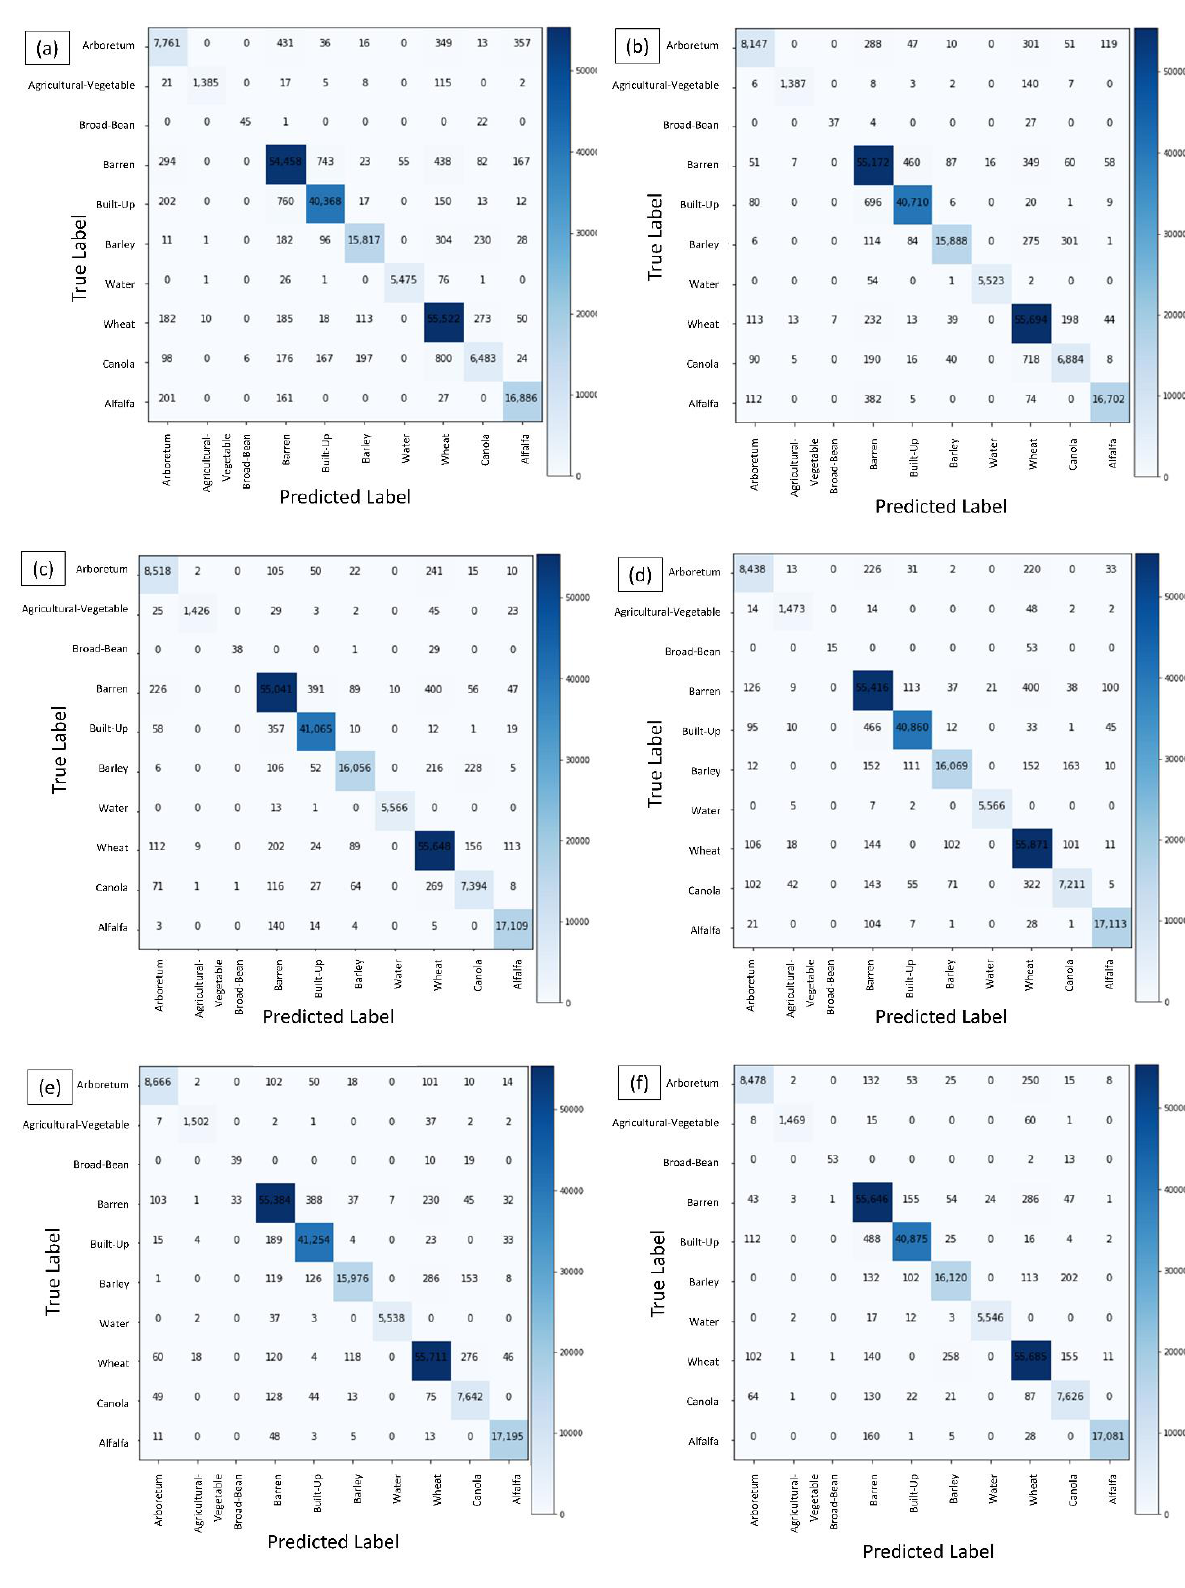
Figure 9. The effects of increasing the number of NDVI datasets in the confusion between different classes obtained by the proposed framework: ( a ) two, ( b ) three, ( c ) four, ( d ) five, ( e ) six, and ( f ) seven months after planting.